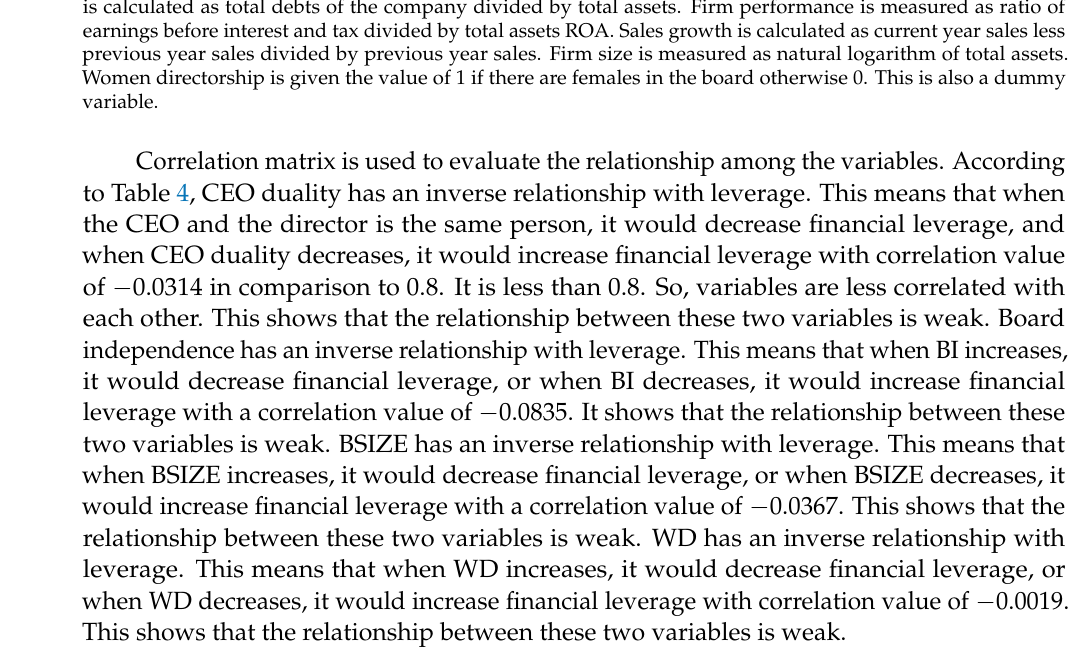
Table 4. Correlation